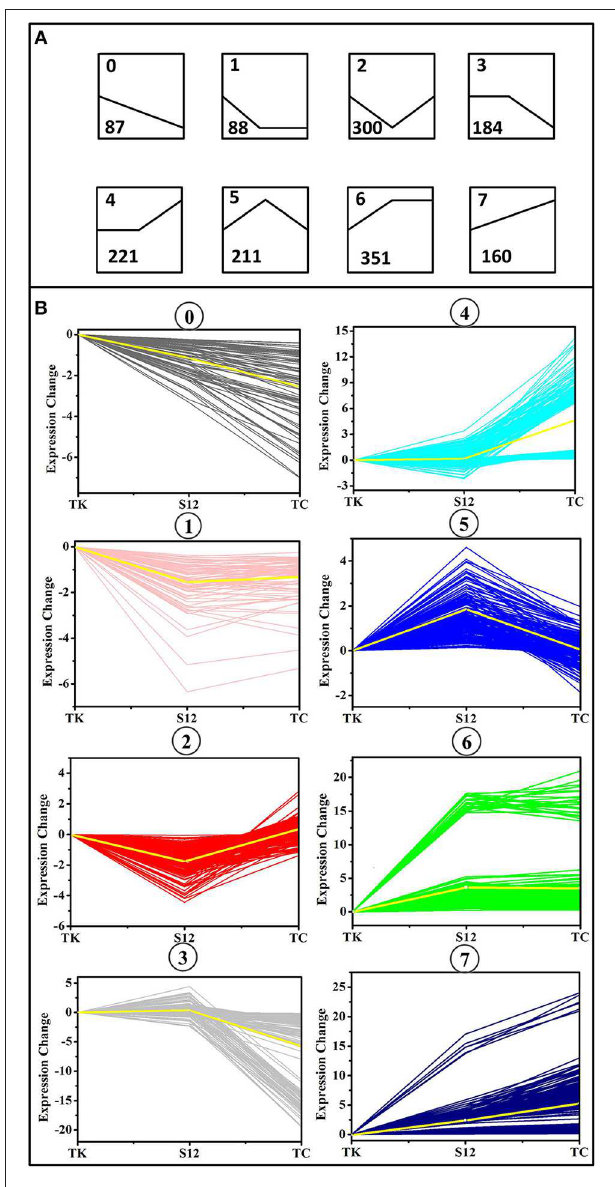
FIGURE 4 | Clusters of differentially expressed genes (DEGs) between the mutant strain TK, Tet 30 Chl 25 , and the initial strain S12. (A) Eight trend models used by gene clustering analysis. The number in the upper left corner of each trend represents the type number to which the trend belongs, and the number in the lower left corner represents the number of genes that fall into the trend. (B) Clusters of differentially expressed genes (DEGs) under various salinomycin production environment. The X axis represents mutants TK, Tet 30 Chl 25 , and the parental strain S12